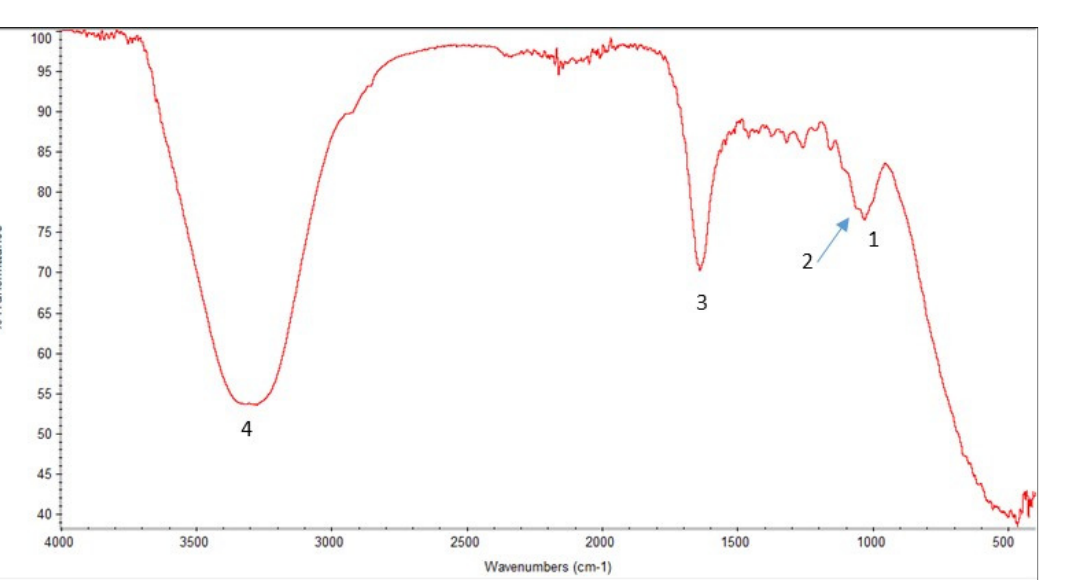
Figure 4. FT-IR spectrum of the nanocellulose. Peak 1 (1027 cm − 1 ): C-O stretching in cellulose. Peak 2 (1164 cm − 1 ): C-O stretching in cellulose and hemicellulose. Peak 3 (1730 cm − 1 ): C=O stretching in hemicellulose. Peak 4 (3000–3399 cm − 1 ): CH stretching in cellulose, hemicellulose.